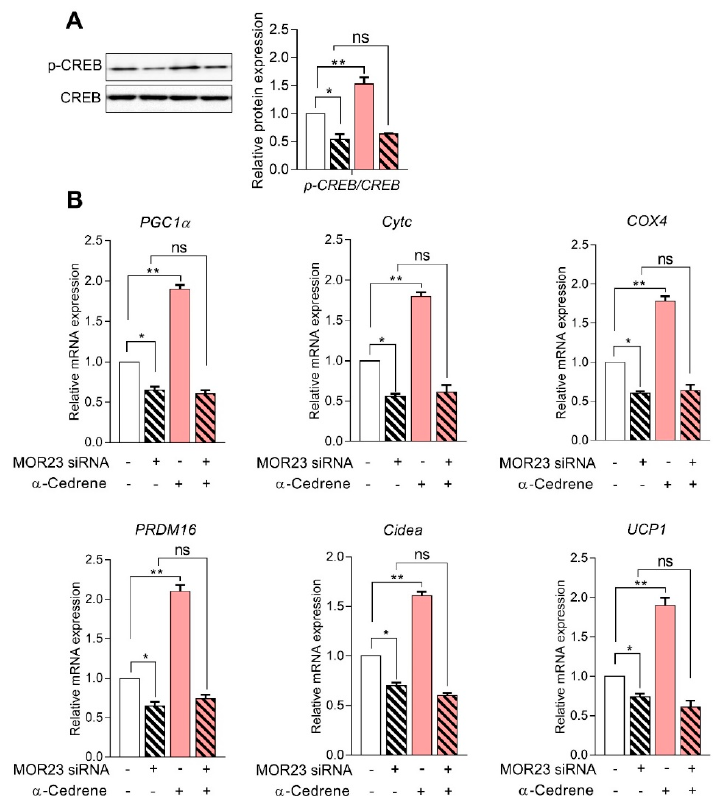
Figure 4. MOR23 depletion decreases the expression of thermogenic and mitochondrial genes. 3T3-L1 preadipocytes were transfected with MOR23 siRNA, stimulated to differentiate in culture 2 days after transfection in the presence of 100 μ M α -cedrene or 50:50 ( v / v ) DMSO/acetonitrile (vehicle). Protein and RNA extraction were performed after adipocyte induction. ( A ) Western blot analysis of phosphor-CREB in 3T3-L1 cells transfected with MOR23 siRNA with or without 100 μ M α -cedrene. ( B ) RT-PCR analysis of the mRNA levels of peroxisome proliferator-activated receptor gamma coactivator 1-alpha ( PGC-1 α ), cytochrome c ( Cytc ), cytochrome c oxidase subunit 4 ( COX4 ), PR domain containing 16 ( PRDM16 ), cell death activator CIDE-A ( Cidea ), and uncoupling protein 1 ( UCP1 ) in 3T3-L1 cells transfected with MOR23 siRNA with or without 100 μ M α -cedrene. The full-length blots are presented in Supplementary Figure S3. The values represent the means ± SEM, n = 3. Significant differences between groups are indicated by asterisks; * p < 0.05; ** p < 0.01; ns, not significant ( p > 0.05).